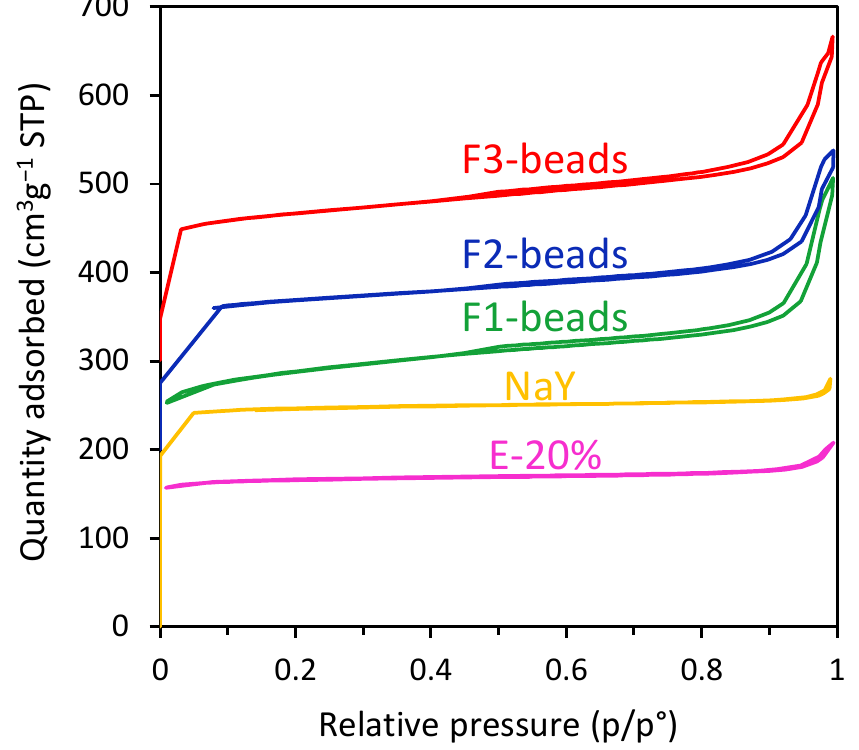
Figure 5. N 2 physisorption isotherms for F1-beads–F3-beads, commercial zeolite Y powder (NaY), and extrudates of commercial zeolite Y (E-20%). The F1-beads isotherm is offset by 100 cm 3 g − 1 , the F2-beads isotherm is offset by 200 cm 3 g − 1 , and the F3-beads isotherm is offset by 300 cm 3 g − 1 along the vertical axis to facilitate their visualization.